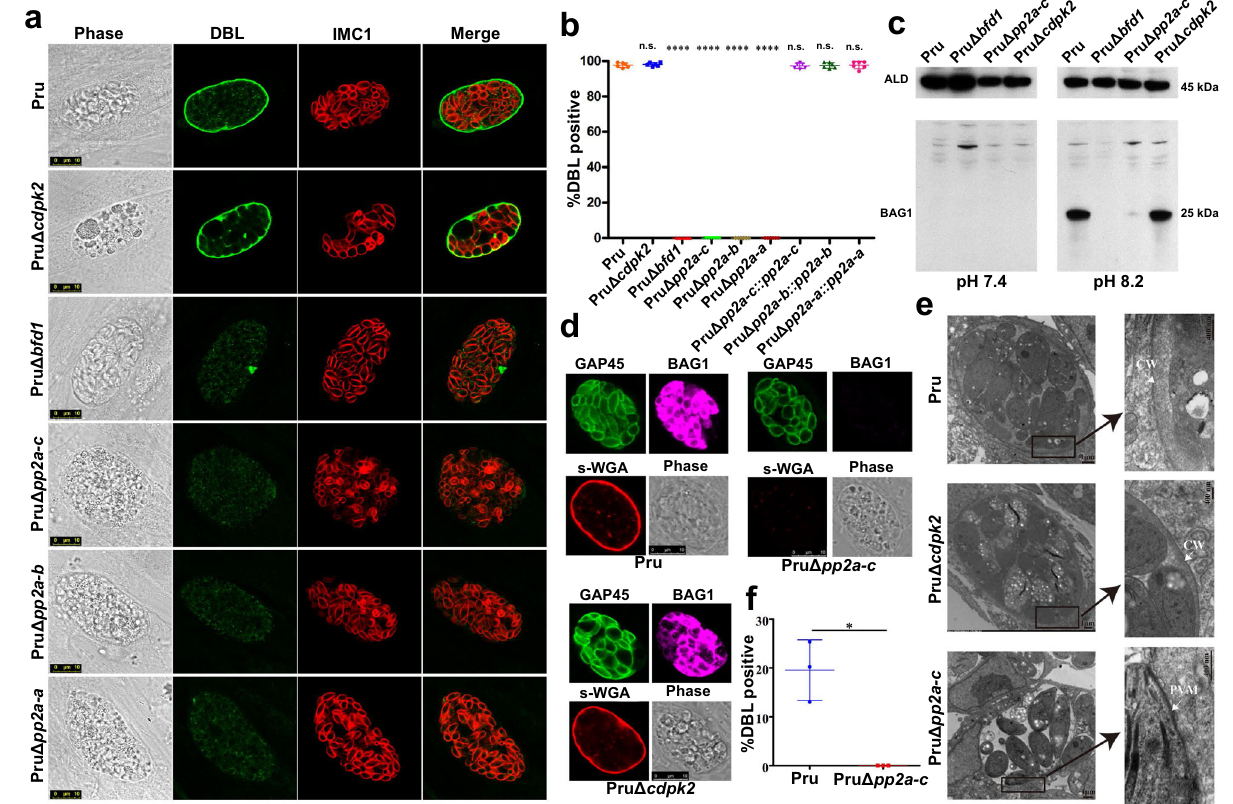
Fig. 3 | PP2A holoenzyme is essential for bradyzoite differentiation in cell culture. a The indicated parasite strains were allowed to infect HFF cells for 4h followed by incubation in an alkaline culture medium without CO 2 for 4 days for induction of bradyzoites. Parasites were stained with anti-IMC1 antibody (red) and bradyzoite cyst wall was detected by FITC- Dolichos bi fl orus lectin (DBL) (green). Pru Δ Bfd1 was used as a negative control for stage conversion. Scale bar, 10 µ m. b Quanti fi cation of differentiation in wild-type, knockout, and complemented strains following 4 days of exposure to alkaline stress. The mean±SD was plotted for six biological replicates, with percentage of DBL positive vacuoles calculated based on at least 100 vacuoles per replicate. Statistical signi fi cance tested by Stu- dent ’ sone-tailed t testandtheindicatedstrainswerecomparedwithPrustrain**** P value<0.0001, n.s.=not signi fi cant. c Western blotting analysis of the tachyzoites (incubated for 4 days under high alkaline culture conditions) by anti-BAG1